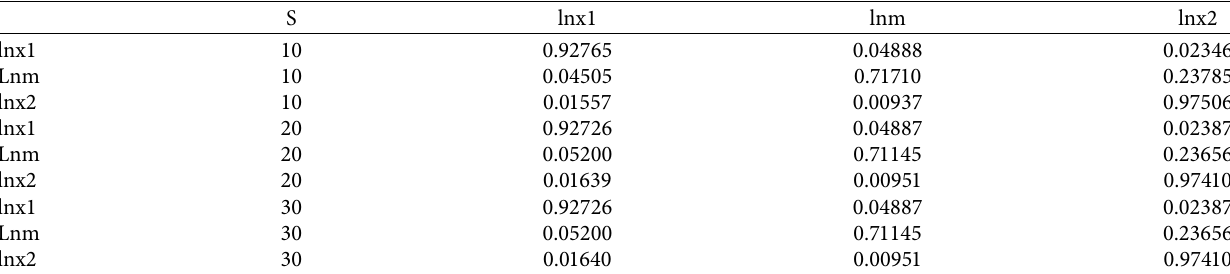
Table 12: Variance decomposition.